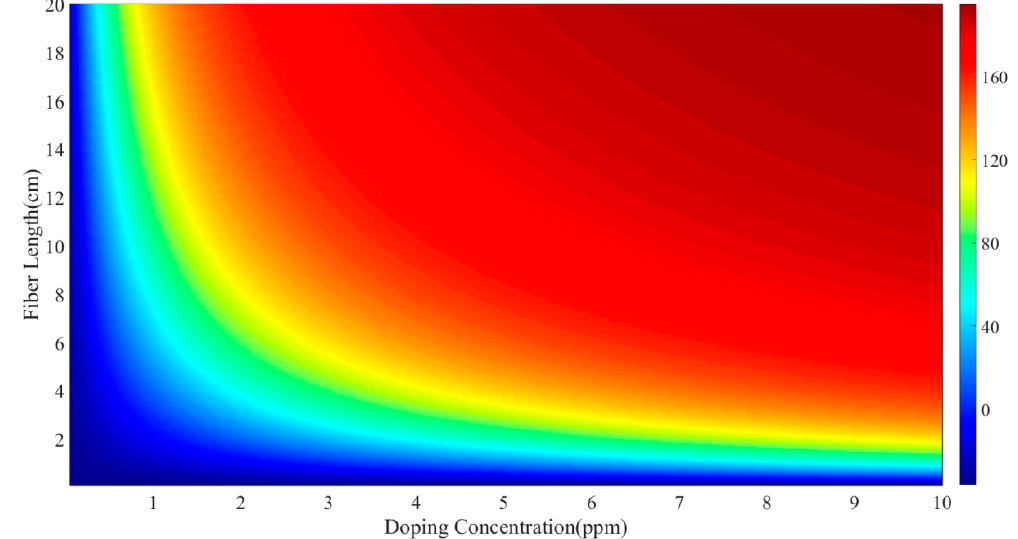
Figure 15. The ASE PTs of POFs with 1–20 cm lengths and 0.1 ppm–10 ppm concentrations.